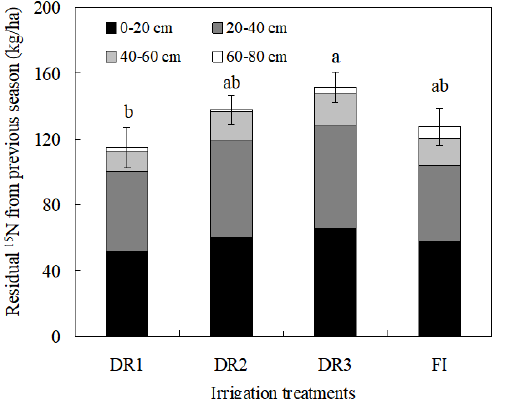
Figure 3. The amount of soil residual 15 N from the previous season and its distribution in different soil layers (DR1, DR2, and DR3 mean the lower irrigation limits of 75%, 65%, and 55% accounting for the field capacity, separately. FI represents furrow irrigation treatment using the same irrigation regime as DR2. The data in the Figure are mean ± SD. The different letters (a, b) indicate significant differences at the level of 0.05 according to Duncan’s multiple range